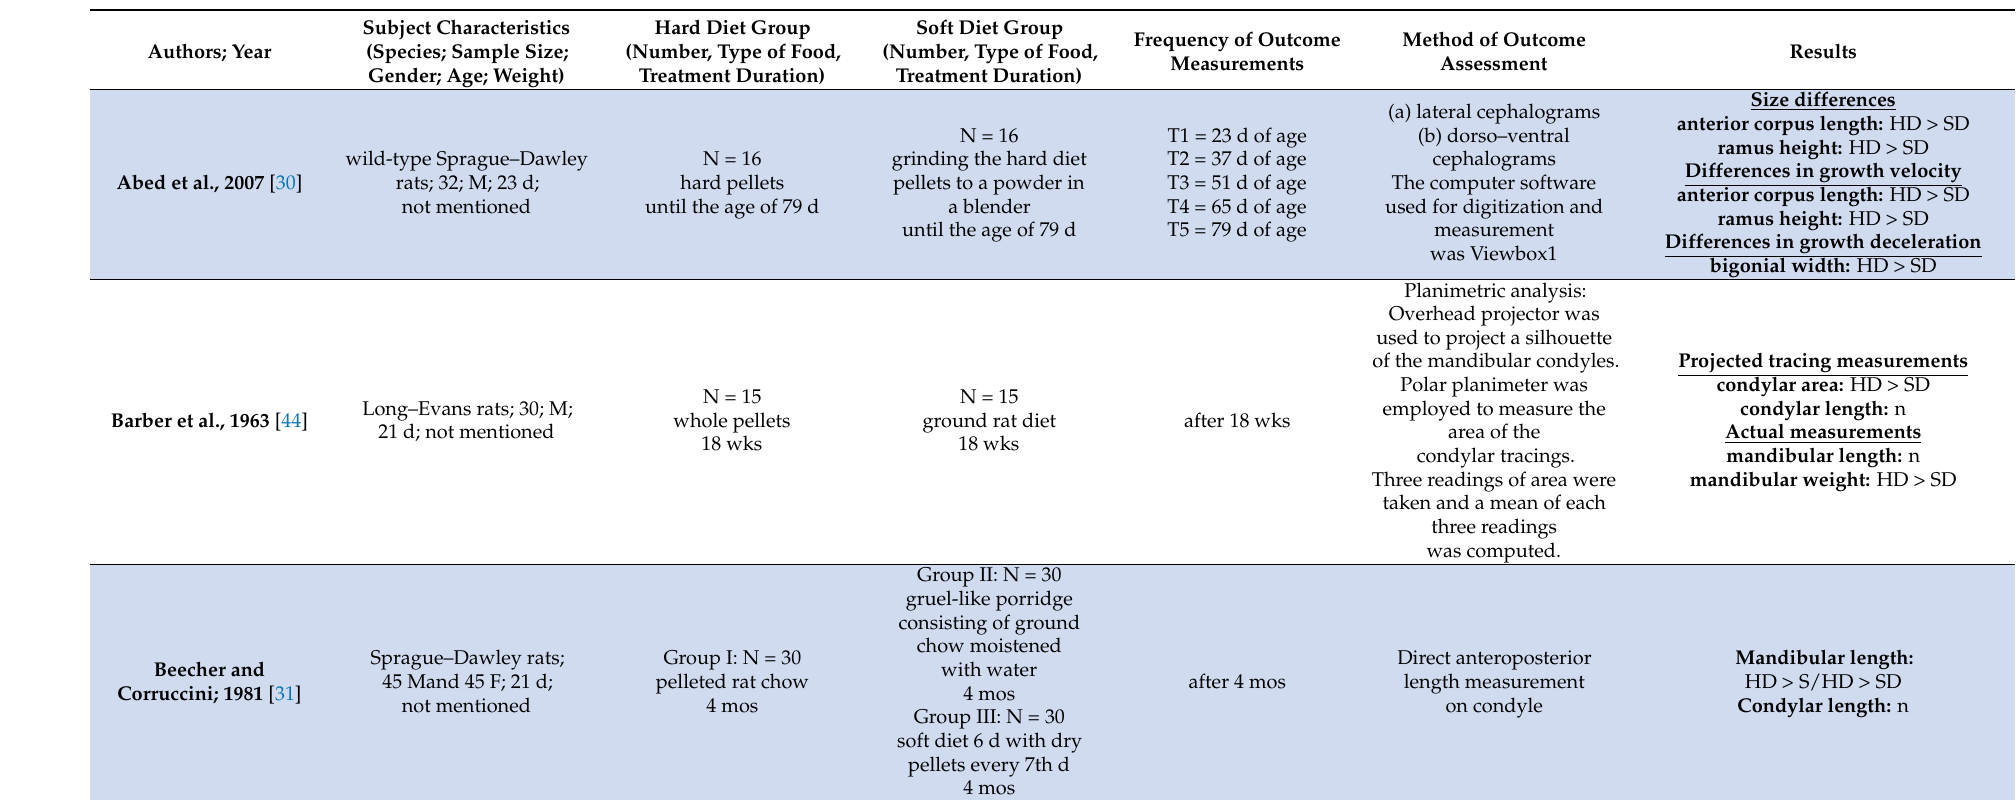
Table 1. Characteristics of the studies included in the systematic